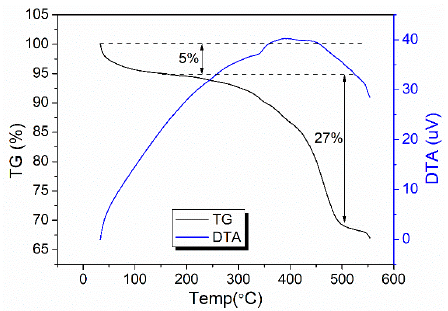
Figure 2. Thermogravimetry/Differential Thermal Analysis (TG/DTA) curve of MOF FeBDC.